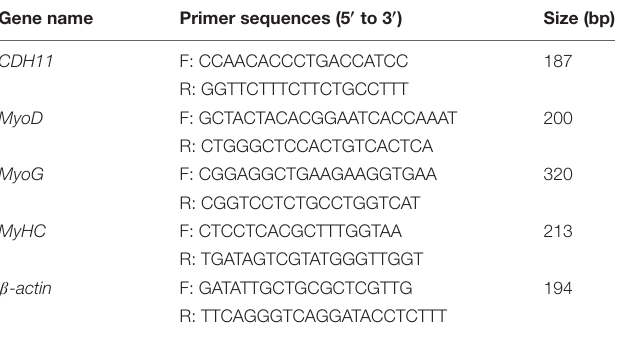
TABLE 3 | Primers used for quantitative real-time PCR